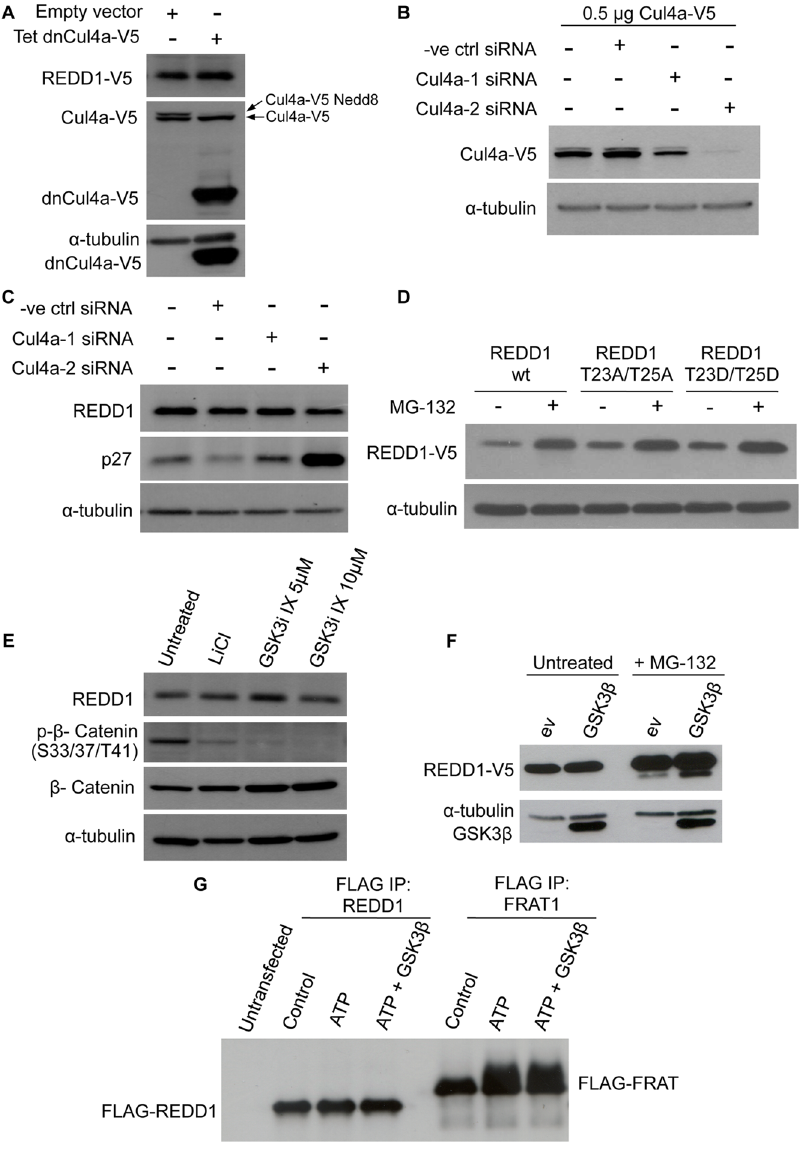
Figure 5. REDD1 is not degraded by Cul4a or phosphorylated by GSK3 b at Thr 23 and Thr25. ( A ) HEK293 cells were transfected with empty vector or tetracycline inducible dnCul4a-V5 pcDNA4/TO (1 m g) and Cul4A-V5 pcDNA3 (0.03 m g) followed by tetracycline (1 m g/ml) induction for 24 hours and cell lysis. ( B ) HEK293 cells were transfected with 0.5 m g Cul4a-V5 pcDNA3 for 15 hours followed by transfection of 20 nM control or Cul4a siRNAs to determine siRNAs efficiency. ( C ) HEK293 cells were transfected with 20 nM control or Cul4a siRNAs for 3 days followed by cell lysis. ( D ) REDD1-V5 pcDNA3 wild type, T23A T25A or T23D T25D plasmids (0.4 m g) were transfected in HEK293 cells for 3 days and treated with 20 m M MG- 132 for 6 hours followed by cell lysis. ( E ) HEK293 cells were treated with 30 mM LiCl or GSK3 inhibitor IX (5 m M or 10 m M) for 20 hours followed by cell lysis. ( F ) HEK293 cells were co-transfected with 0.2 m g REDD1-V5 pcDNA3 and 0.3 m g GSK3 b pcDNA3 or empty pcDNA3 for 3 days followed by MG- 132 (20 m M) treatment for 6 hours followed by cell lysis. ( G ) HEK293 cells were transfected with 3 m g FLAG-REDD1 or FLAG-FRAT1 for 3 days followed by cell lysis and FLAG immunoprecipitation. In vitro phosphorylation of REDD1 and FRAT1 was carried out as described in Materials and Methods.